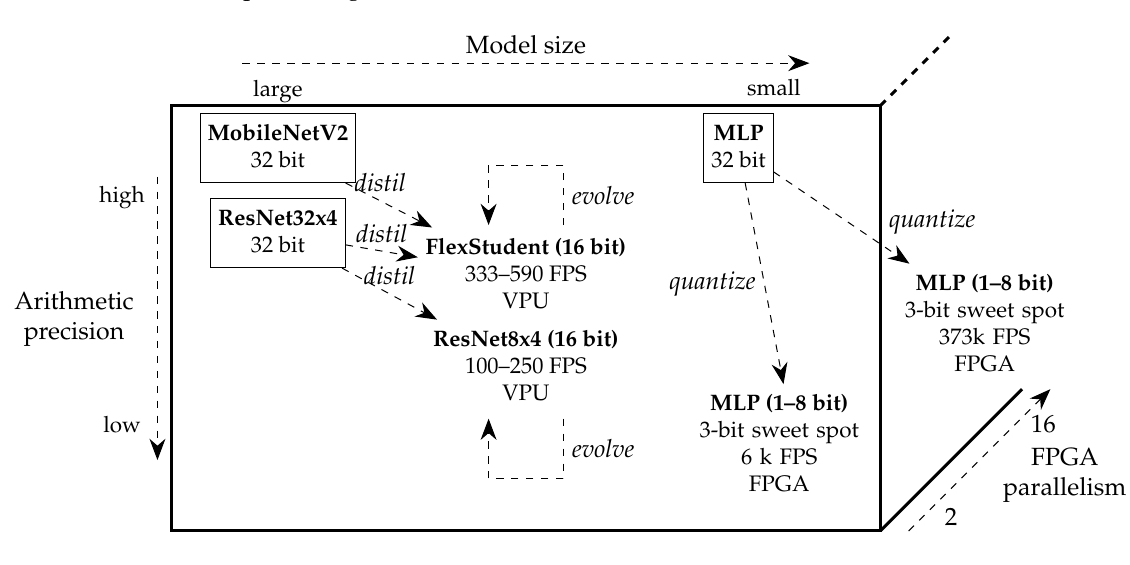
Figure 11. Varying Precision and Model Archiectures Figure 11. Varying precision and model